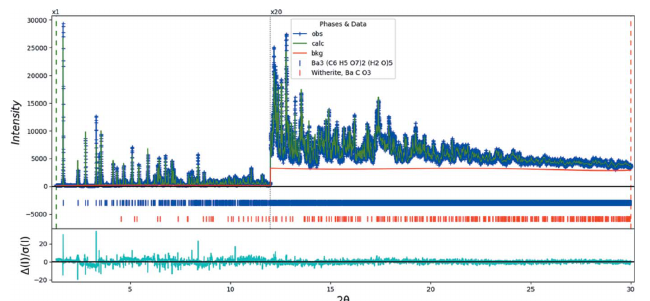
Figure 5 Rietveld plot for (I). The blue crosses represent the observed data points, and the green line is the calculated pattern. The cyan curve is the normalized error plot. The vertical scale has been multiplied by a factor of 20 (cid:6) for 2 (cid:7) > 12.0 (cid:3) . The row of blue tick marks indicates the calculated reflection positions, and the red tick marks indicate the peak positions for the BaCO 3 impurity. The red line is the background